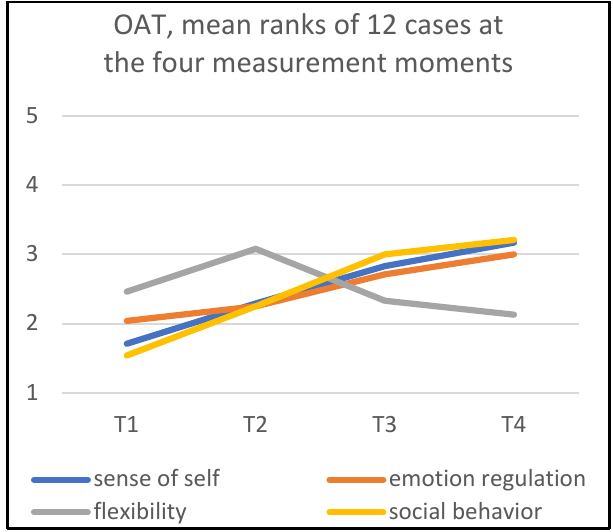
Figure 7. Mean ranks of OAT.